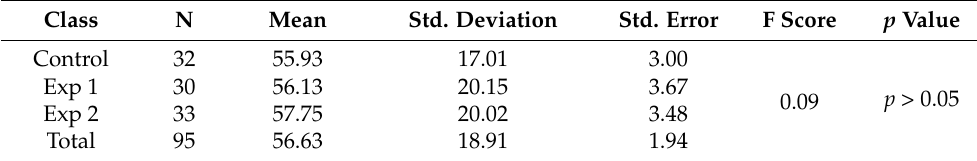
Table 1. ANCOVA results of the pre-test student achievement from 3 classes. Class N